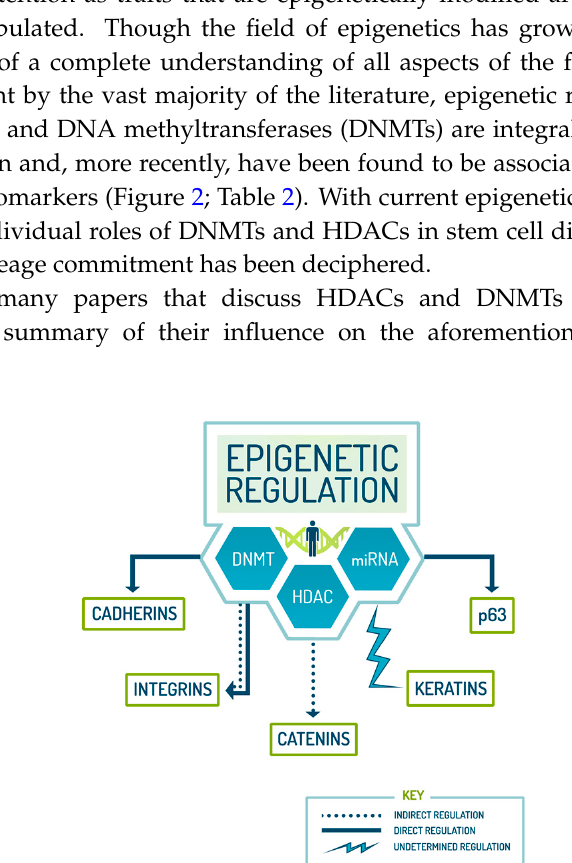
Figure 2. Epigenetic regulation of ESC biomarkers. Epigenetics has several roles in various processes. This image is a depiction of the relationship between epigenetic modifiers and ESC biomarkers. As indicated by the arrows, these modifiers directly regulate cadherins and p63, as well as indirectly regulate catenins. Note that integrins are both directly and indirectly modulated by epigenetics. As with keratins, an epigenetic relationship has been established. However, it still remains to be ascertained whether the relationship is of a direct or indirect nature and whether the resultant epigenetic modification fosters an overexpressed or inhibited phenotype of the protein. DNMT: DNA methyltransferase; HDAC: histone deacetylase. Table 2. Epigenetic modifiers and their roles in stem cell regulation. DNMT: DNA methyltransferase; HDAC: histone deacetylase.